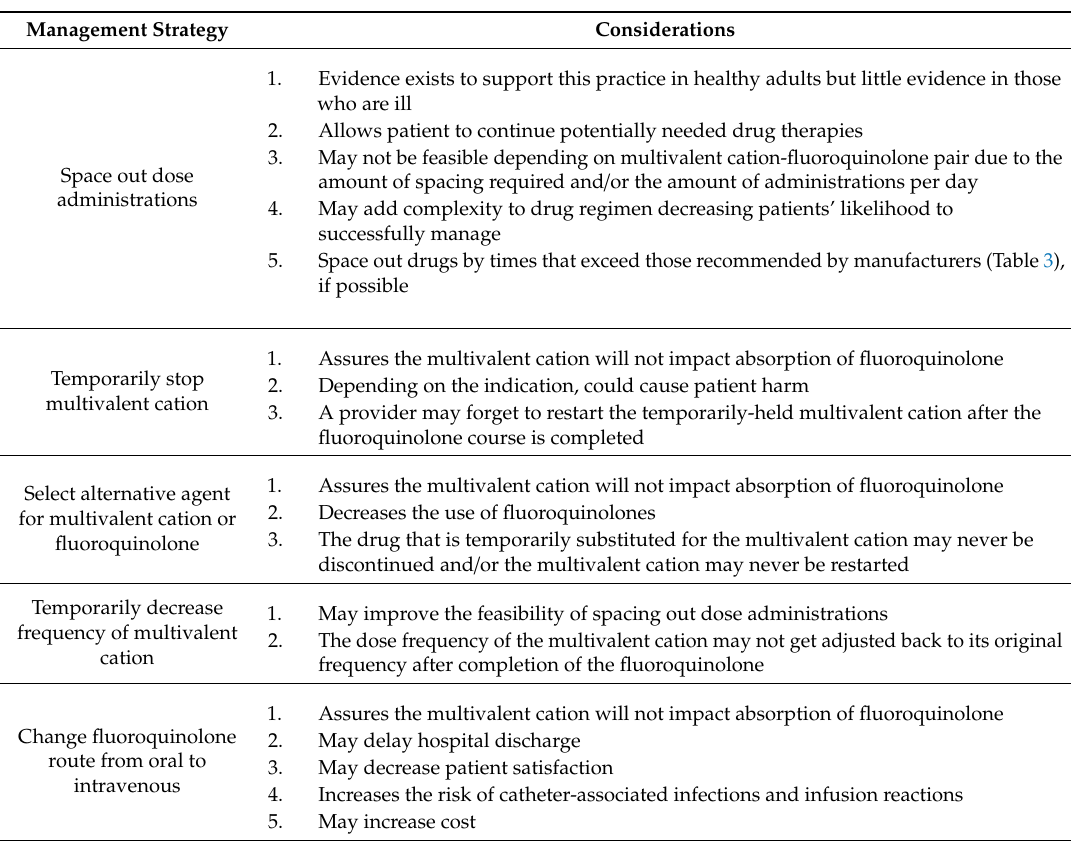
Table 2. Fluoroquinolone-multivalent cation drug-drug interaction management